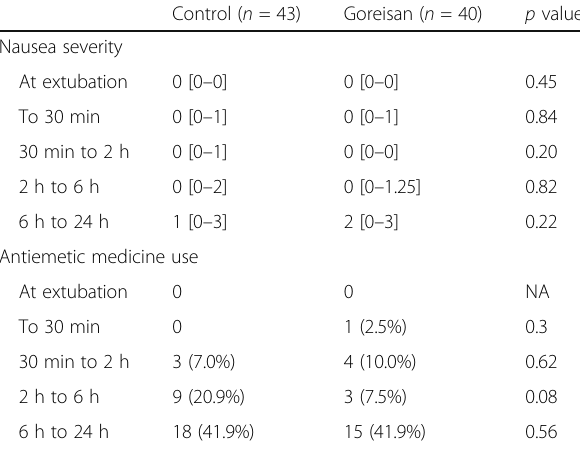
Table 6 Nausea severity and antiemetic use